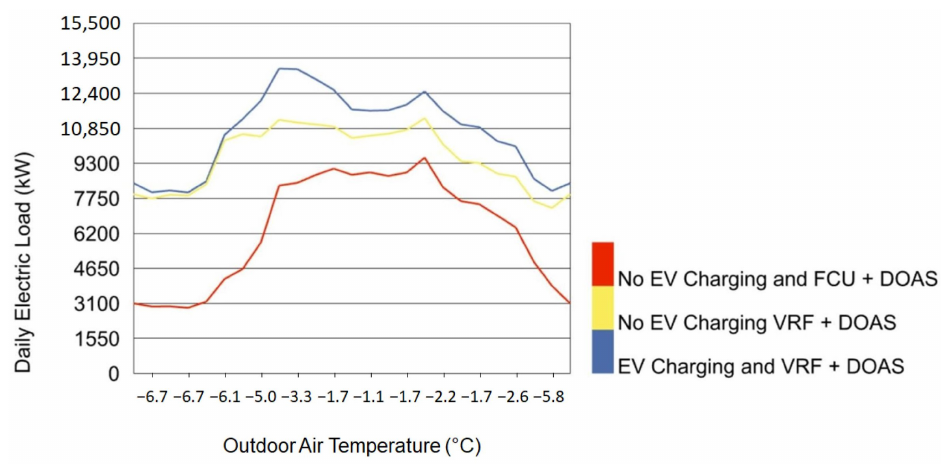
Figure 18. Hourly electric load profile for scenarios of increasing electrification during an extreme cold